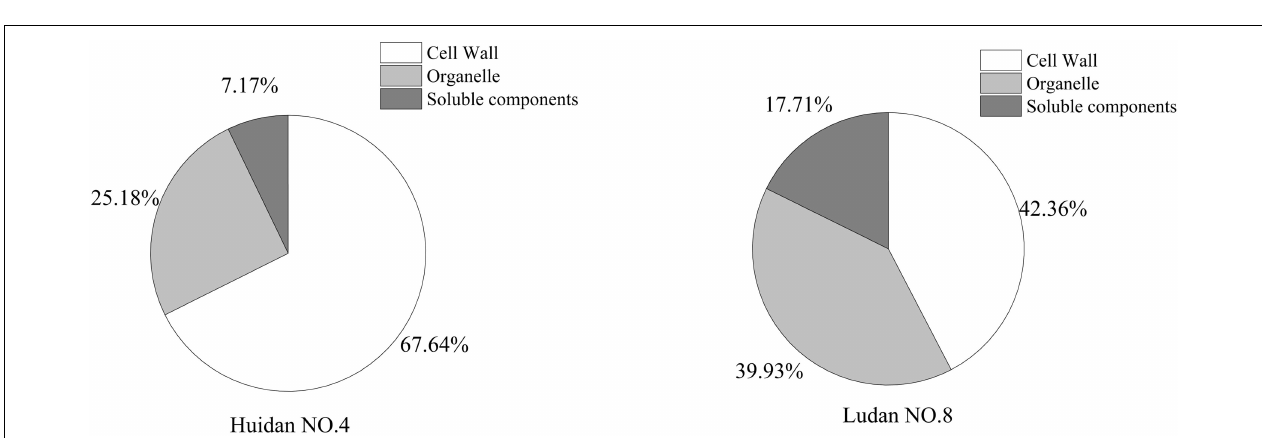
FIGURE 2 | Subcellular distribution of lead in two maize